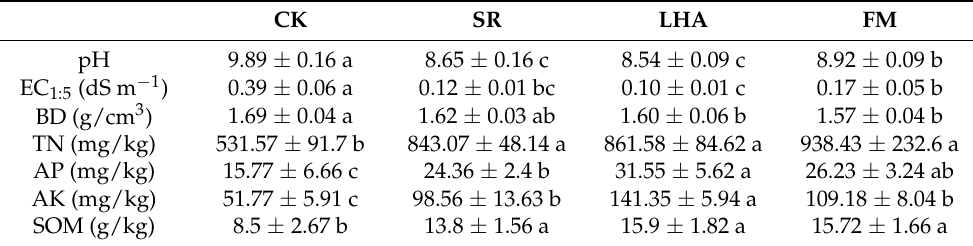
Table 3. Effects of different organic amendment materials on soil physical and chemical properties.